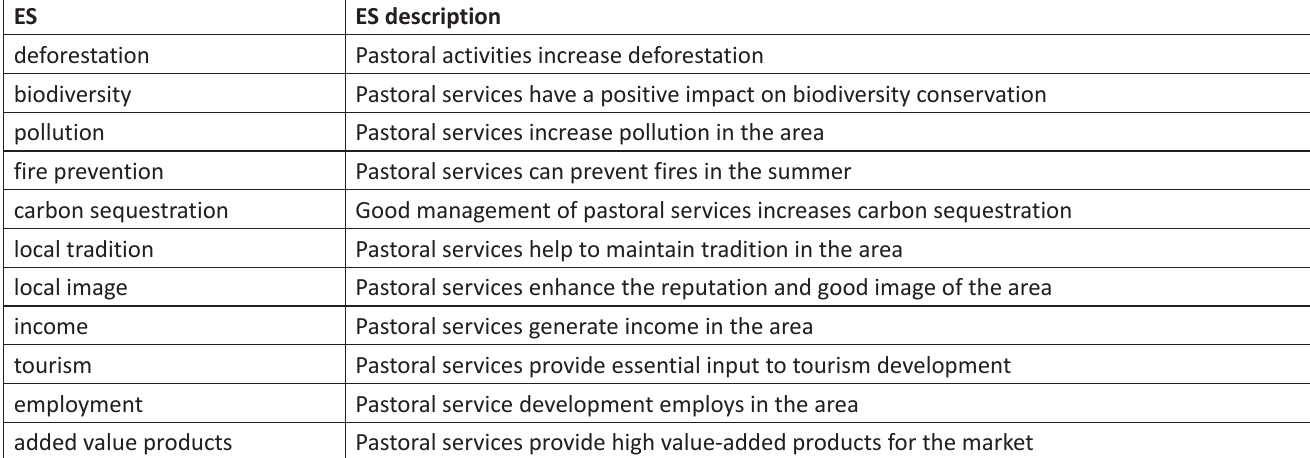
Table 1. Ecosystem services (ES) from the perspective of